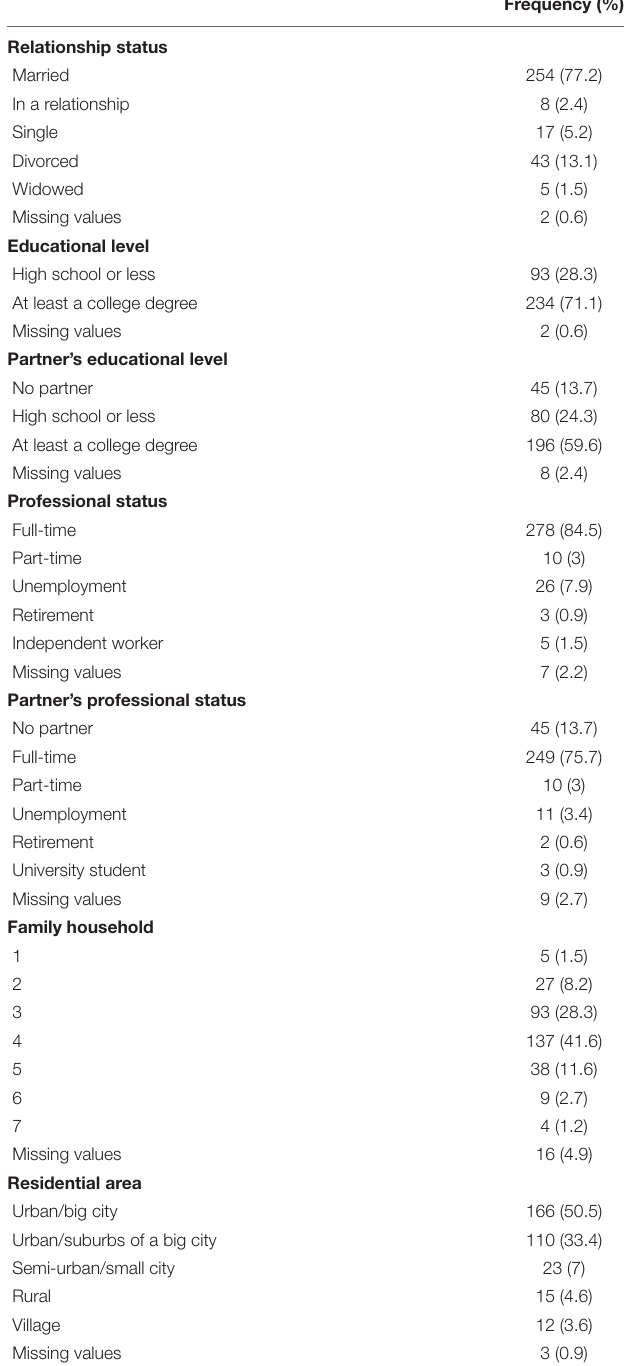
TABLE 1 | Characteristics of the study sample ( n =